Question: What form of chart is displayed?
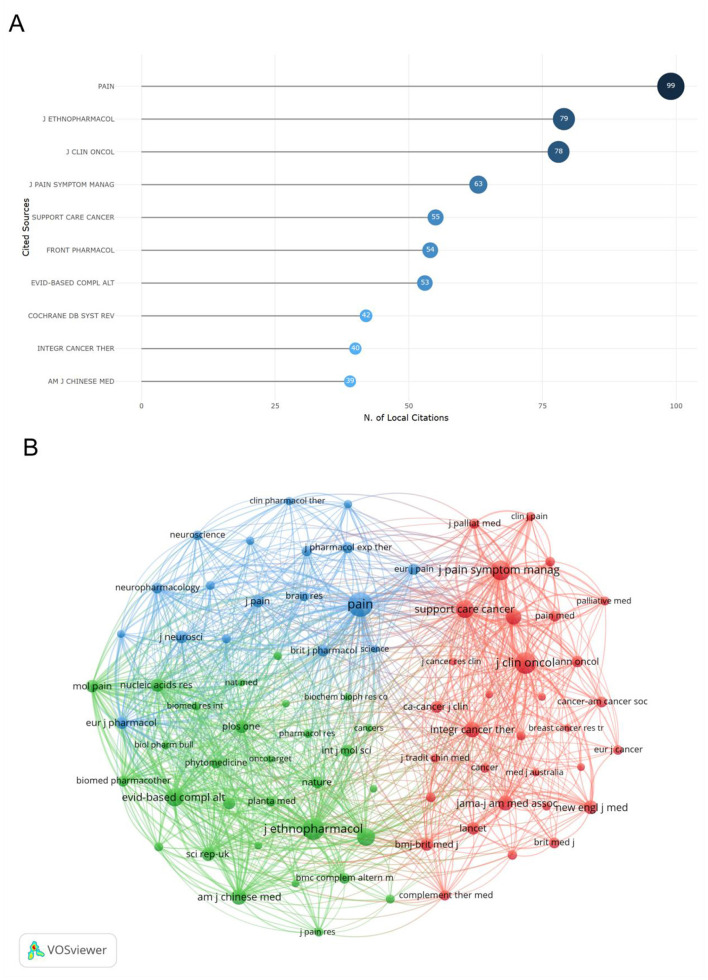
Answer: bar